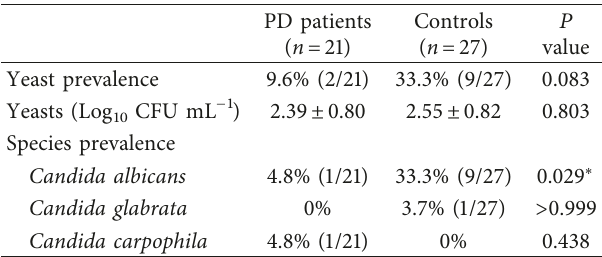
Table 3: Prevalence and quantification of yeast colonizers in peritoneal dialysis (PD) patients and